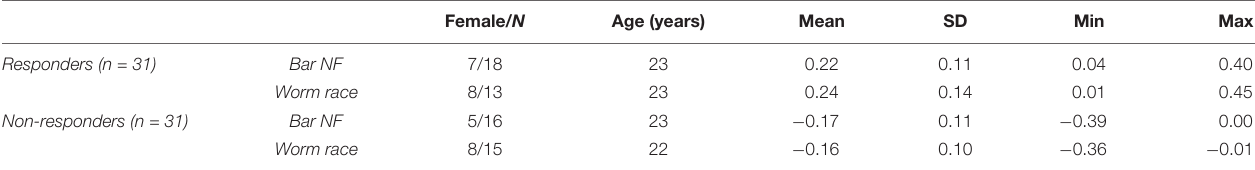
TABLE 1 | Descriptive statistics for the z-transformed SMR slopes, sorted by responder group and type of feedback screen.